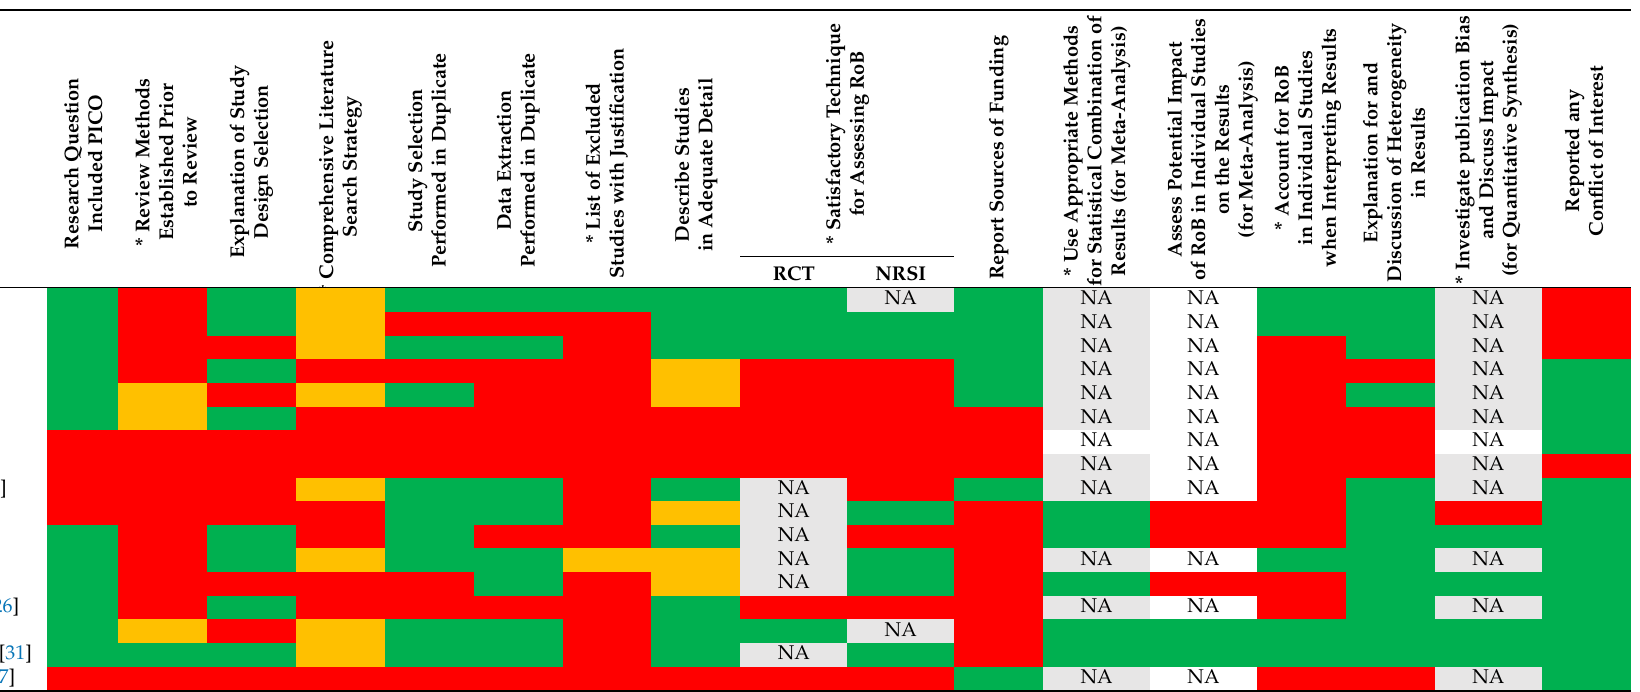
Table 4. Quality appraisal of the included systematic reviews using the AMSTAR-2